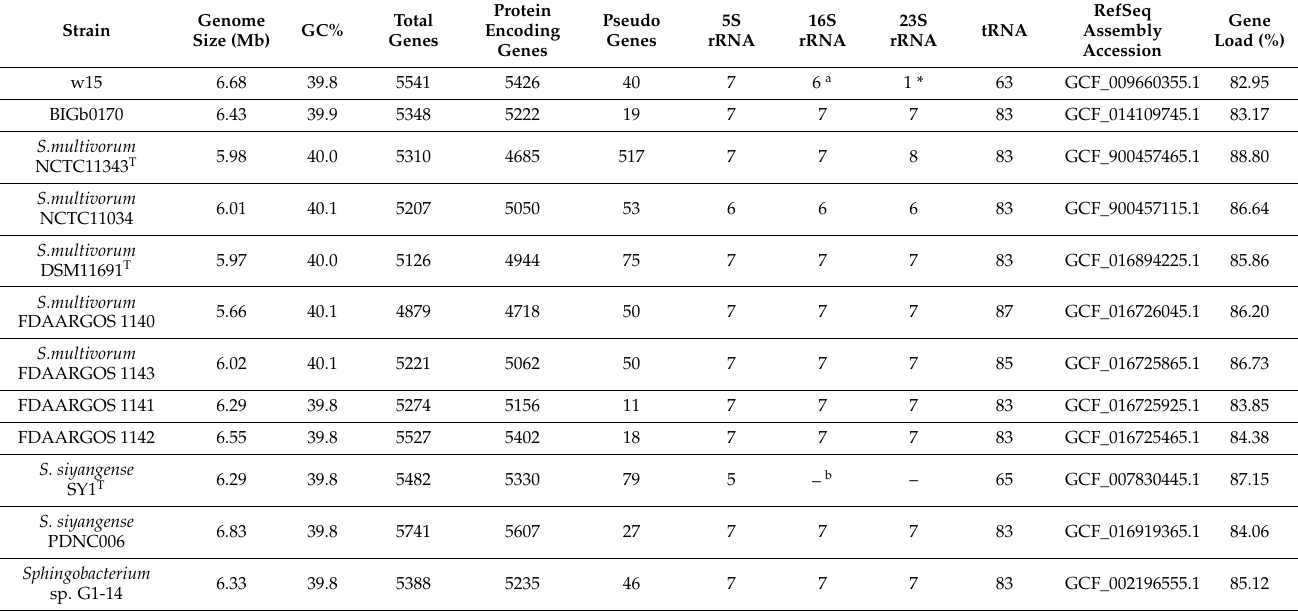
Table 1. Genome information of strains used in this